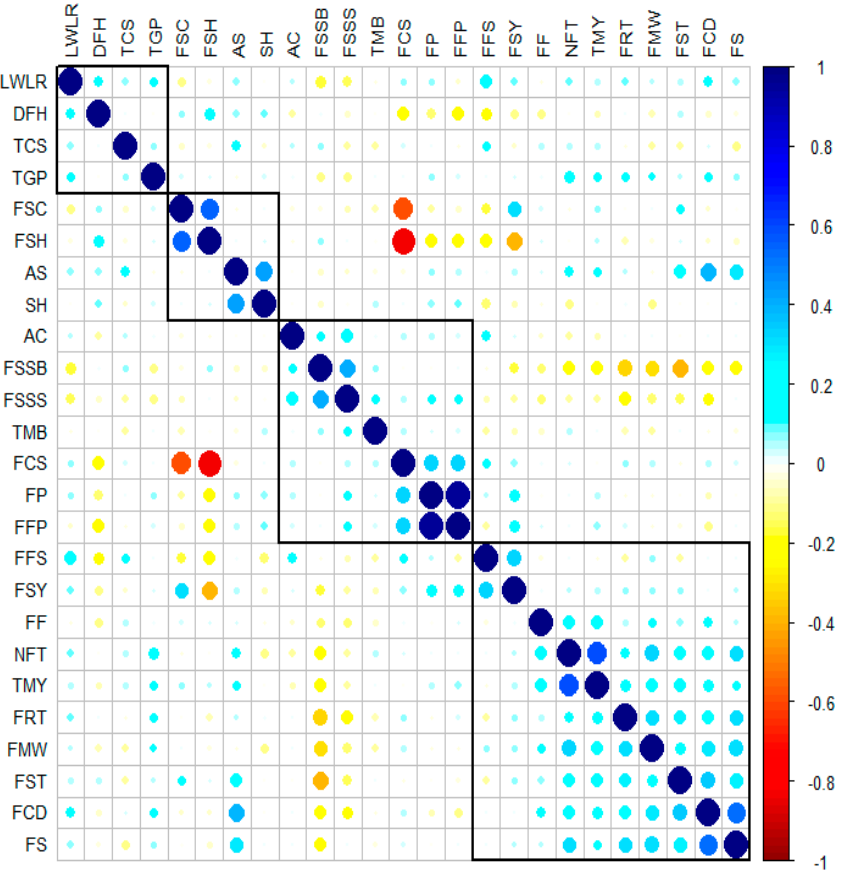
Figure 2. Spearman correlation coefficients among 25 morphological and pomological traits of 221 pomegranate genotypes. Tree Crown Shape ( TCS ); Tree Growth Power ( TGP ); Thorn in Mature wood Branch ( TMB ); Length − to − width Leaf Ratio ( LWLR ); Flower Position ( FP ); Flower Formation Site ( FFS ); Dominant Flowering Habit ( DFH ); Fruitful Flowers Percentage ( FFP ); Flower Cup Diameter ( FCD ). Fruit Size ( FS ); Fruit Skin thickness ( FST ); Fruity Skin Sensitivity to Burst ( FSSB ); Fruit Skin Sensitivity to Sunburn ( FSSS ); Fruit Flavor ( FF ) ; Fruit Ripening Time ( FRT ); Fruit Skin Color ( FSC ); Fruit Shape ( FSH ); Fruit Crown Shape ( FCS ); Fruit symmetry ( FSY ); Aril Size ( AS ); Seed Color ( SC ); Seed Hardness ( SH ); Number of fruits in tree ( NFT ); Fruit mean weight (g) ( FMW ); Tree mean yield ( TMY